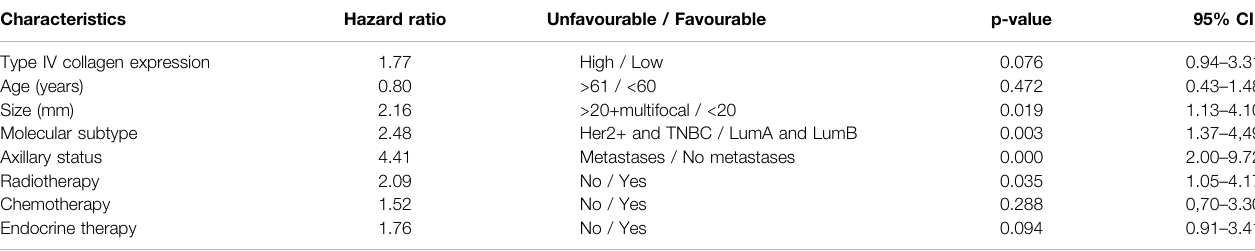
TABLE 3 | Multivariable Cox regression analysis of clinicopathological variables affecting metastatic disease. Tumor size larger than 20 mm or multifocal tumors, Her2+ and TNBC molecular subtypes, axillary metastasis, and no radiotherapy received signi fi cantly affects distant metastasis in this cohort.